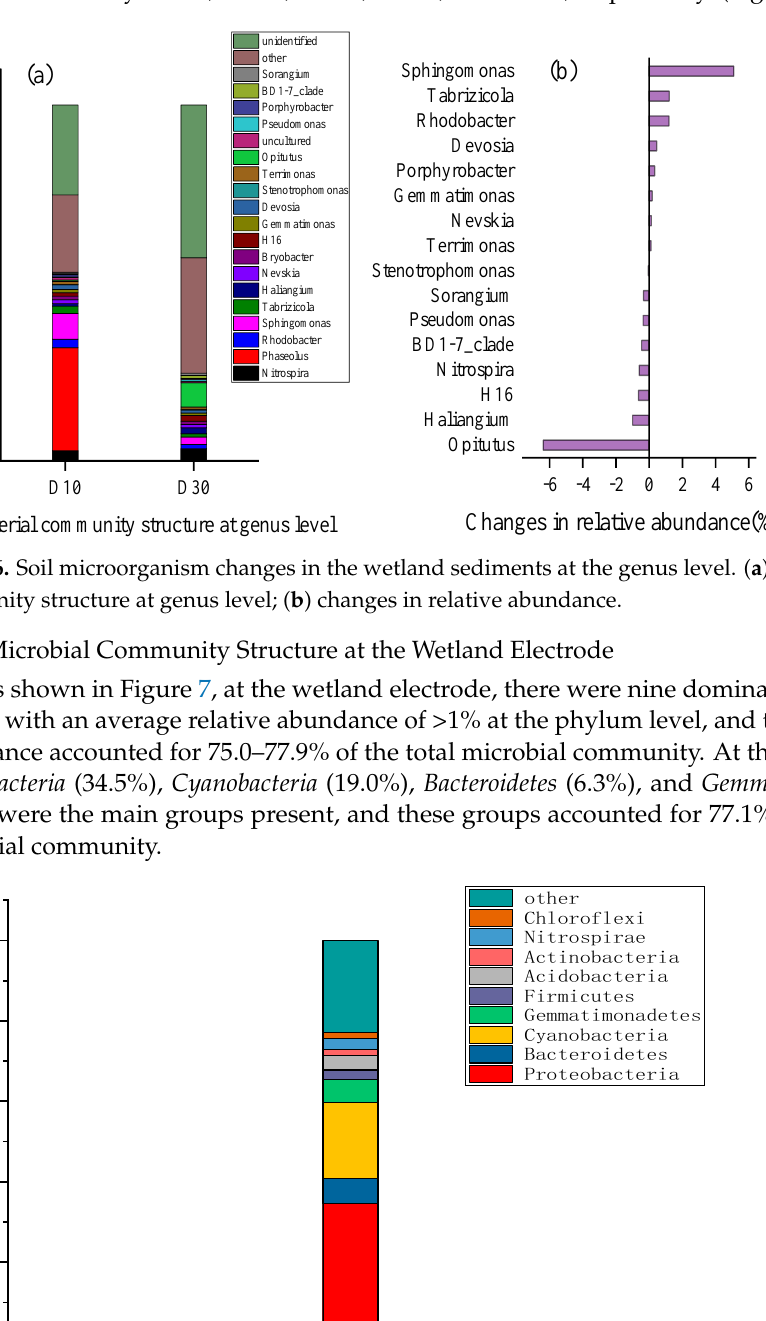
Figure 5. Soil microorganism changes in the wetland sediments at the phylum level. ( a ) Soil bacte- rial community structure at phylum level; ( b ) changes in relative abundance.